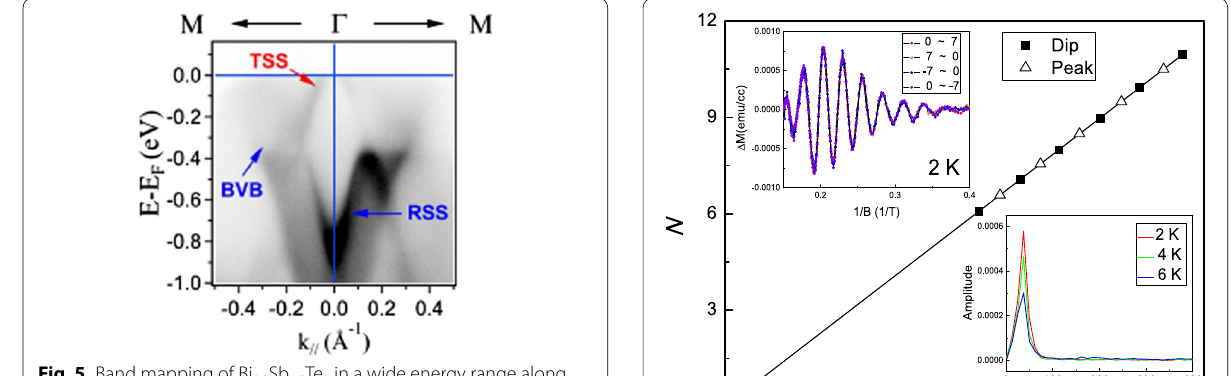
Fig. 5 Band mapping of Bi 0.3 Sb 1.7 Te 3 in a wide energy range along Ŵ –M direction using photon energy 24 eV. The Dirac point can be determined at 80 meV above the Fermi level with the extrapolation of the linear dispersion of topological surface state